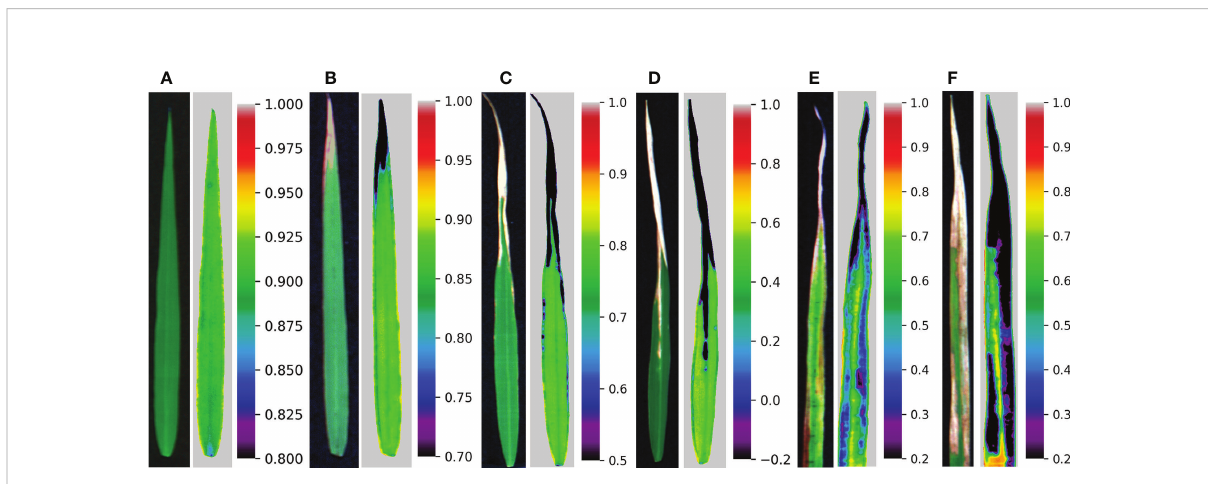
FIGURE 6 RGB images and corresponding visualization images of NDSCI. From left to right are disease severity of (A) 0, (B) 1, (C) 2, (D) 3, (E) 4, and (F) 5, respectively.